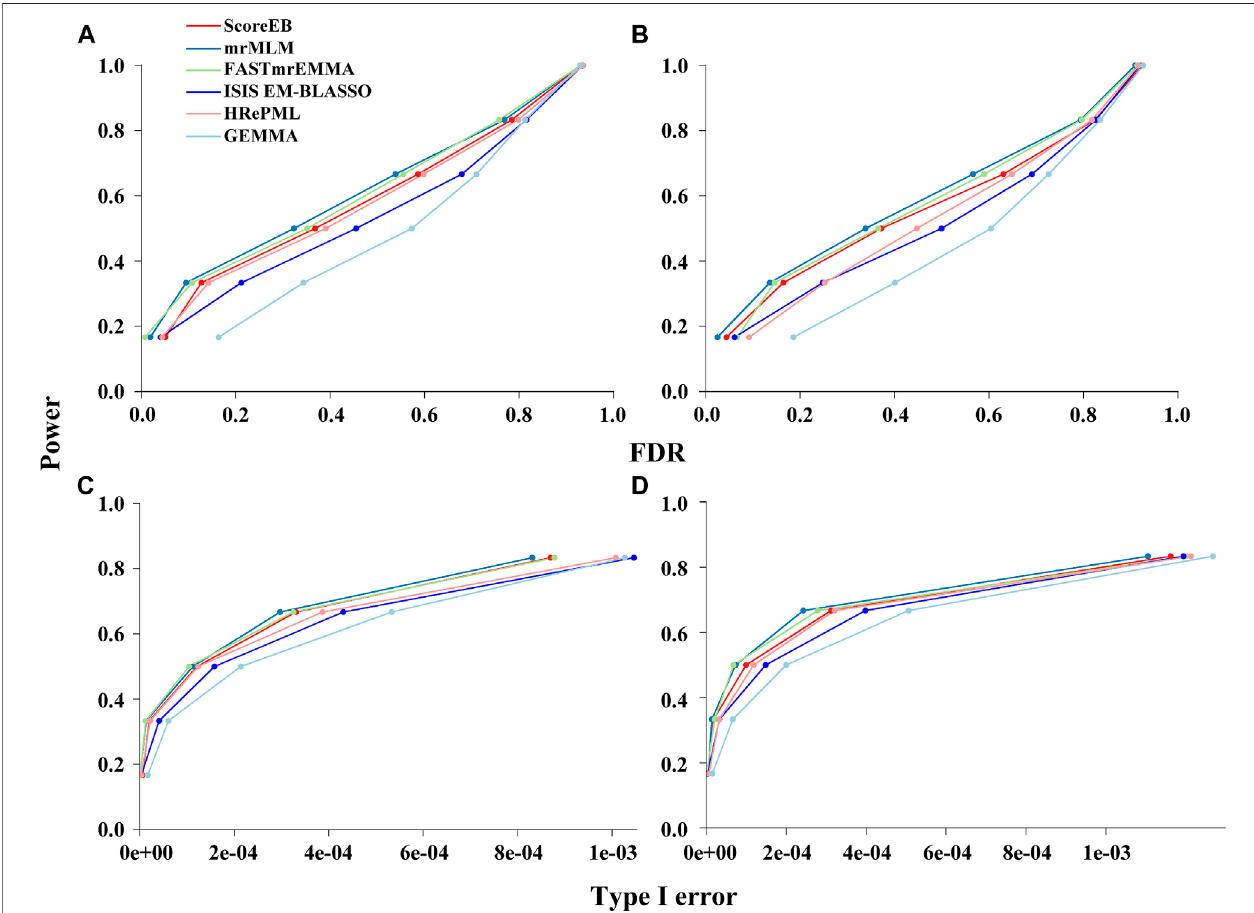
FIGURE1| Performancesofsixmethods(ScoreEB:afastscoretestintegratedwithEmpiricalBayes,mrMLM:multi-locusrandom-SNP-effectmixedlinearmodel, FASTmrEMMA: multi-locus random-SNP-effect EMMA, ISIS EM-BLASSO: iterative modi fi ed-sure independence screening EM-Bayesian lasso, HRePML: hybrid of restrictedandpenalizedmaximumlikelihoodandGEMMA:genome-wideef fi cientmixedmodelassociation)usingsimulationdata.Statisticalpowerunderdifferentlevels of FDR in simulation 1 (A) and simulation 2 (B) , and statistical power under different levels of Type I error in simulation 1 (C) and simulation 2